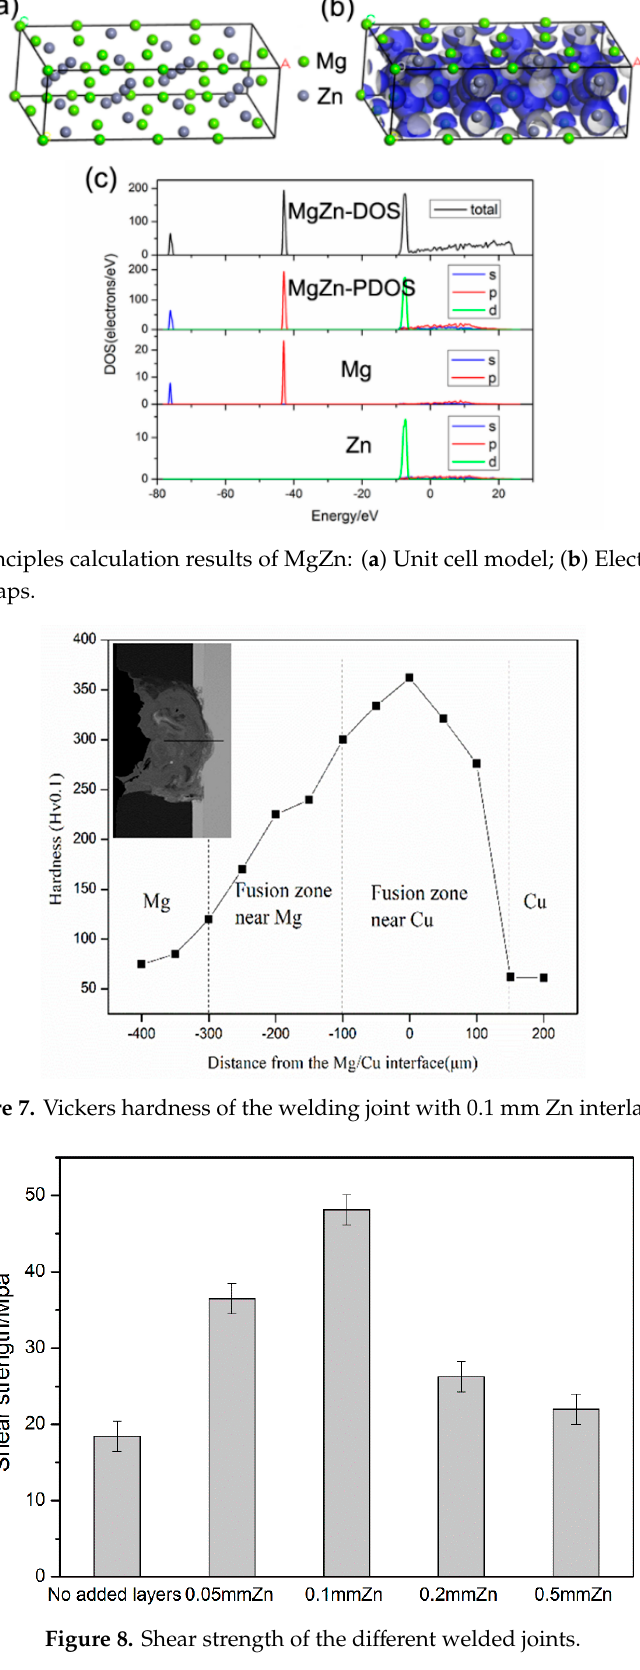
Figure 8. Shear strength of the different welded joints.